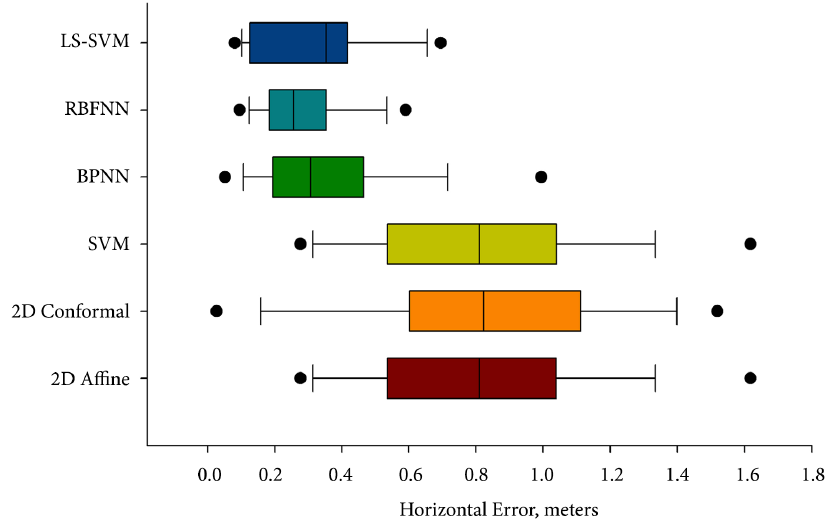
Figure 6. Horizontal positional error variation based on the testing